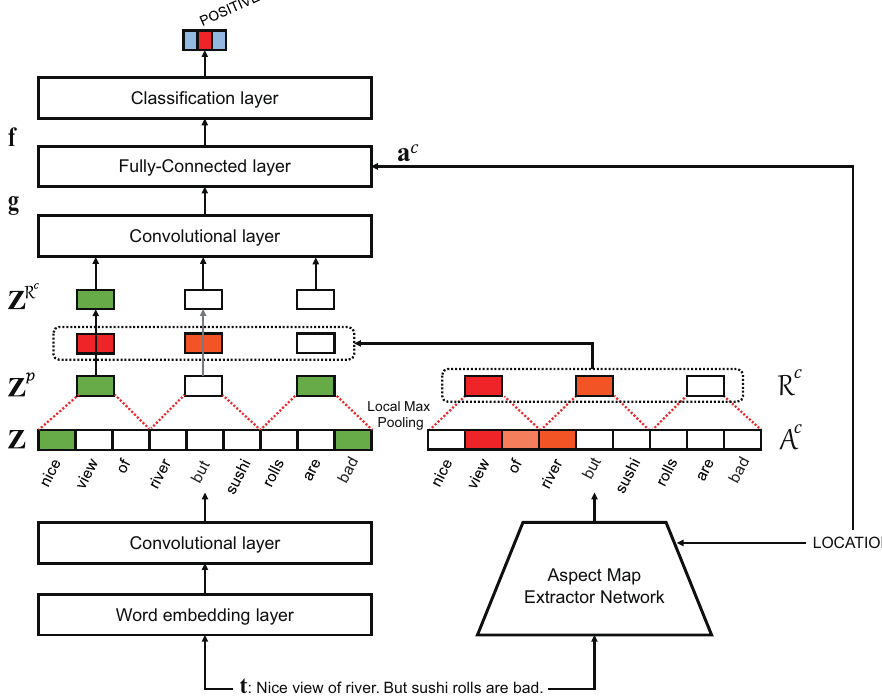
Figure 7. Architecture of aspect map-based sentiment analysis network (AMSAN). Aspect map for LOCATION is used to identify a neighboring word “ nice ” as an aspect-specific sentiment expression. For this, local max pooling is adopted for both the aspect map and convolutional feature map of